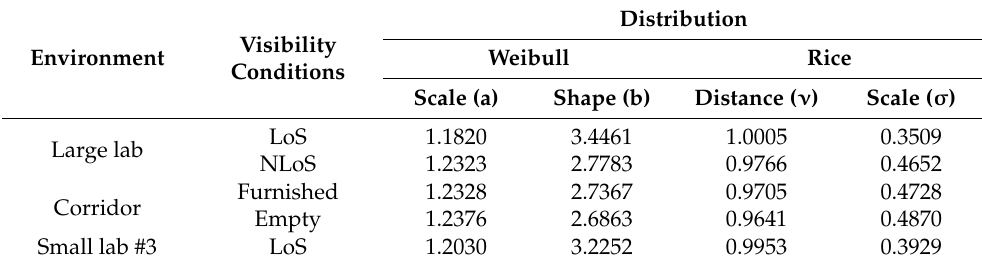
Table 4. Values for the different parameters of statistical distributions at 5 GHz